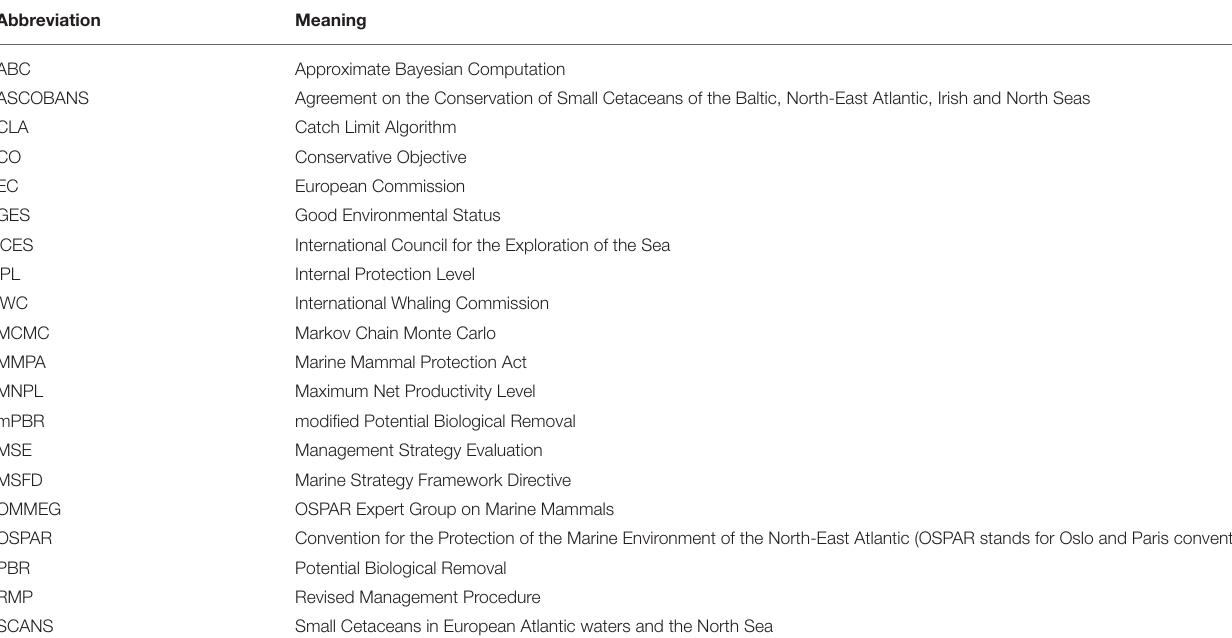
TABLE 1 | Abbreviation used in the